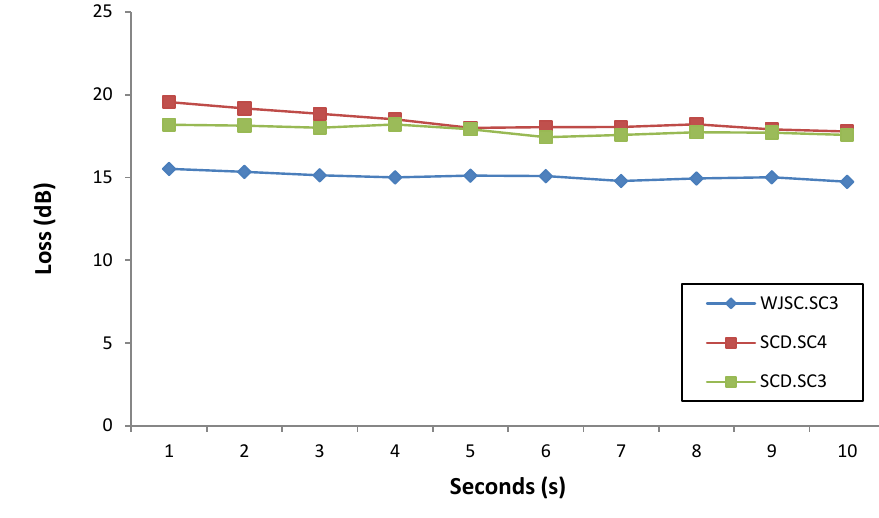
Figure 7. Power loss (dB) against time for selected samples for the three different cell line (all samples taken from Day